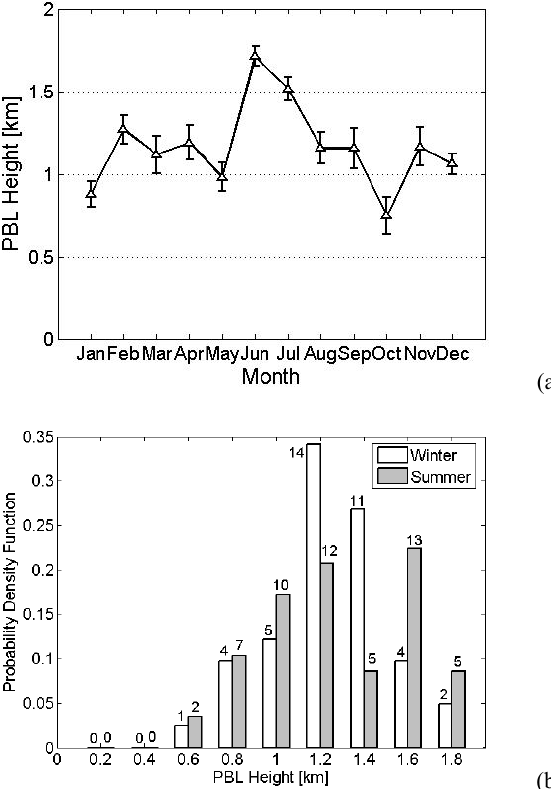
Fig. 6. Lidar-derived daytime PBL height: (a) Annual cycle; (b) probability density function. The numbers above the bars indicate the number of observation days. 5